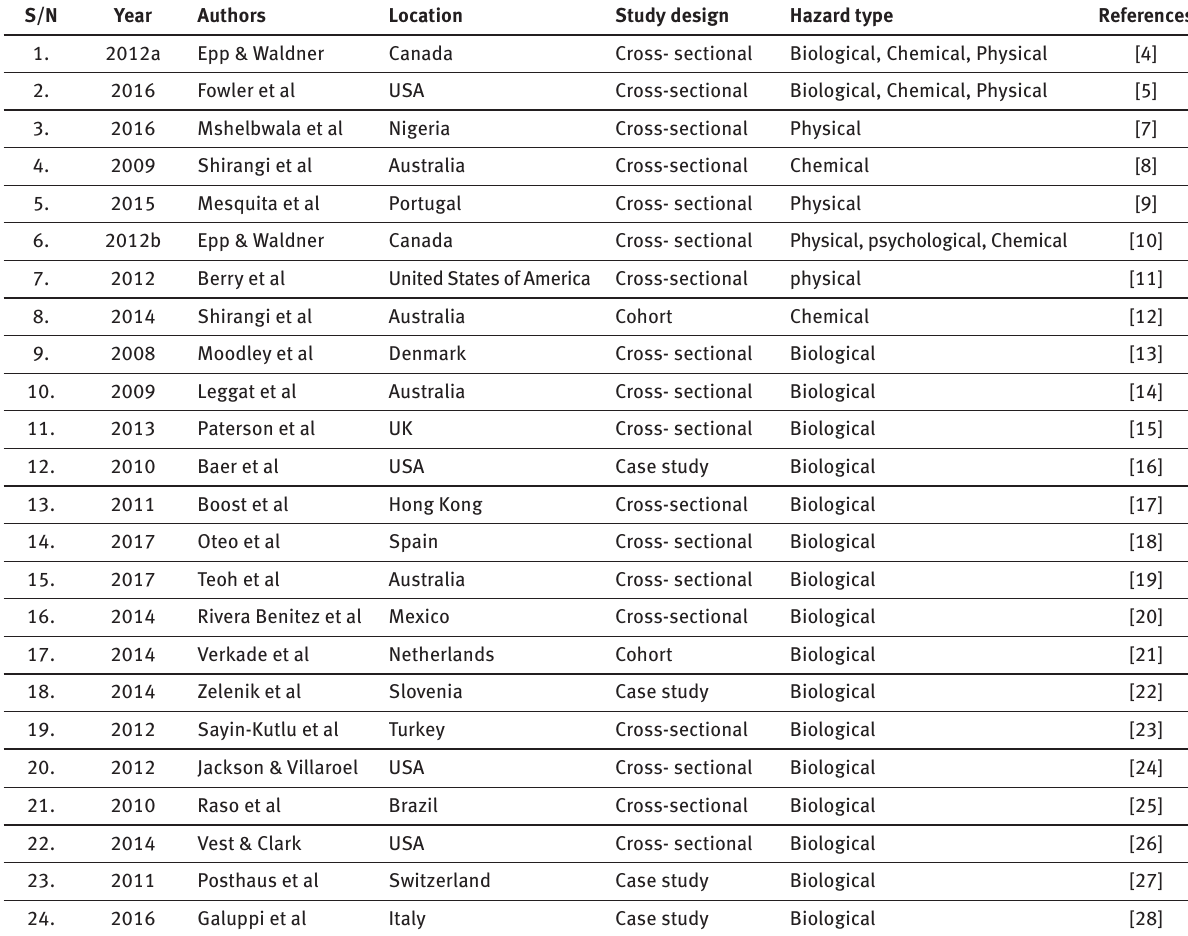
Table 1 Summary of identified article characteristics according to year, authors, location, study design, and hazard